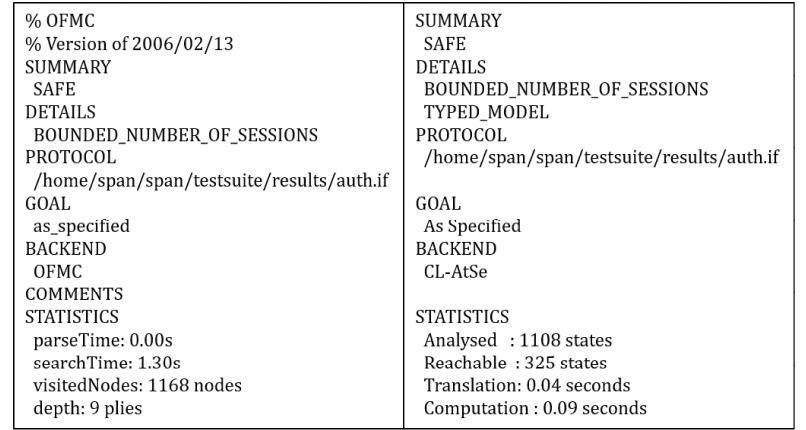
Figure 6. AVISPA evaluation results.